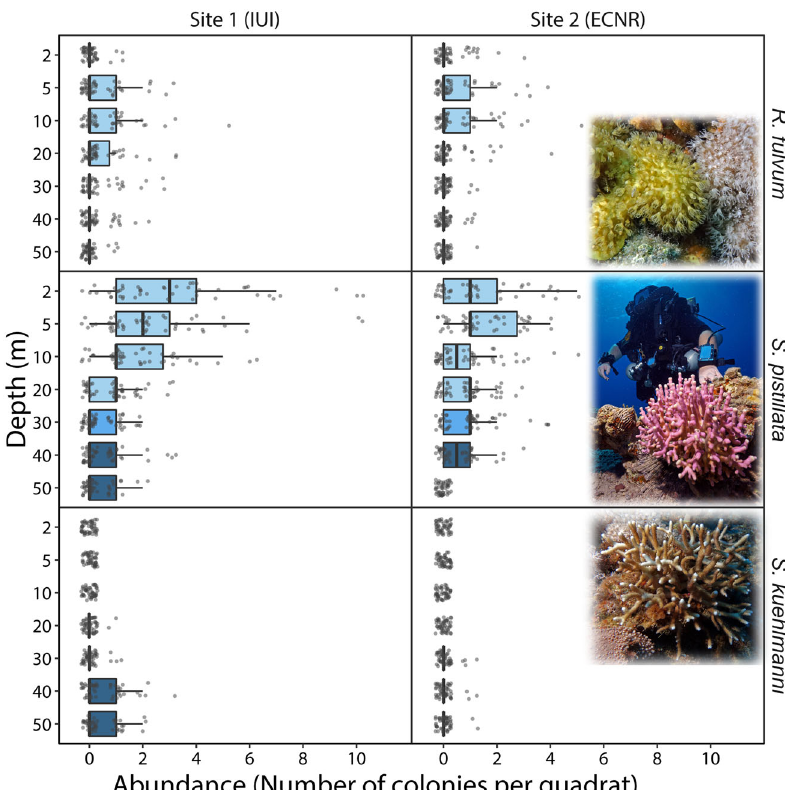
Fig. 1 Abundance of the three focal species at the two study sites along a 2 – 50 m depth gradient. The abundance is presented as the number of colonies per quadrat via box plots, with center lines indicating the medians, boxes indicating the lower and upper quartiles, and whiskers indicating 1.5x interquartile range. Points represent individual quadrat counts ( n = 50 for each site and depth